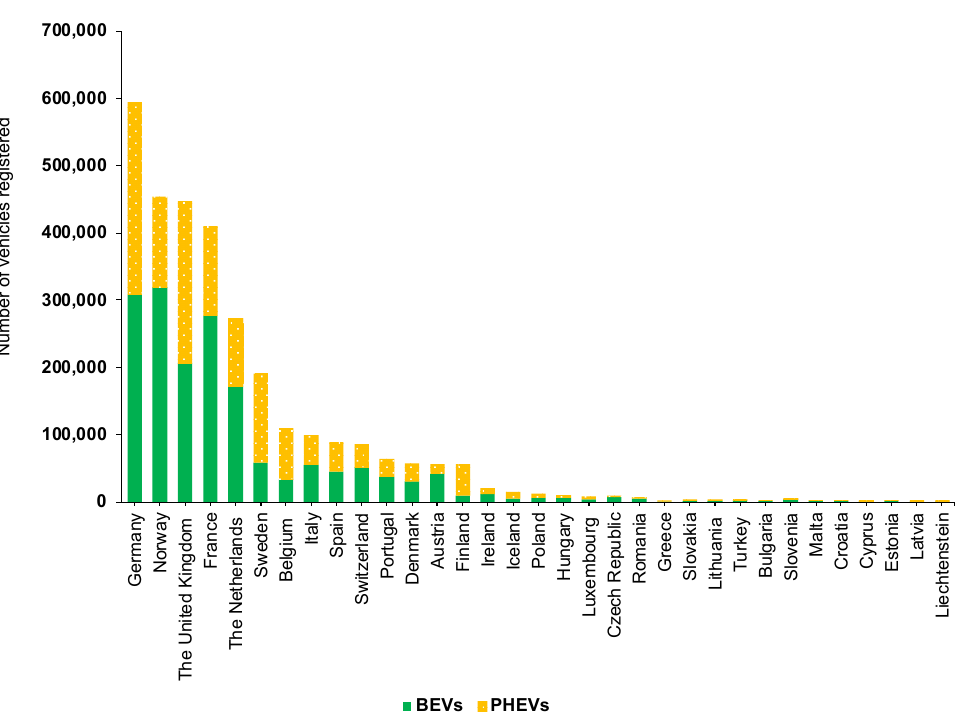
Figure 4. The total number of BEVs and PHEVs registered in 27 EU countries + Norway and the United Kingdom in 2020. The authors created this figure with data from the European Alternative Fuels Observatory (EAFO) [19].